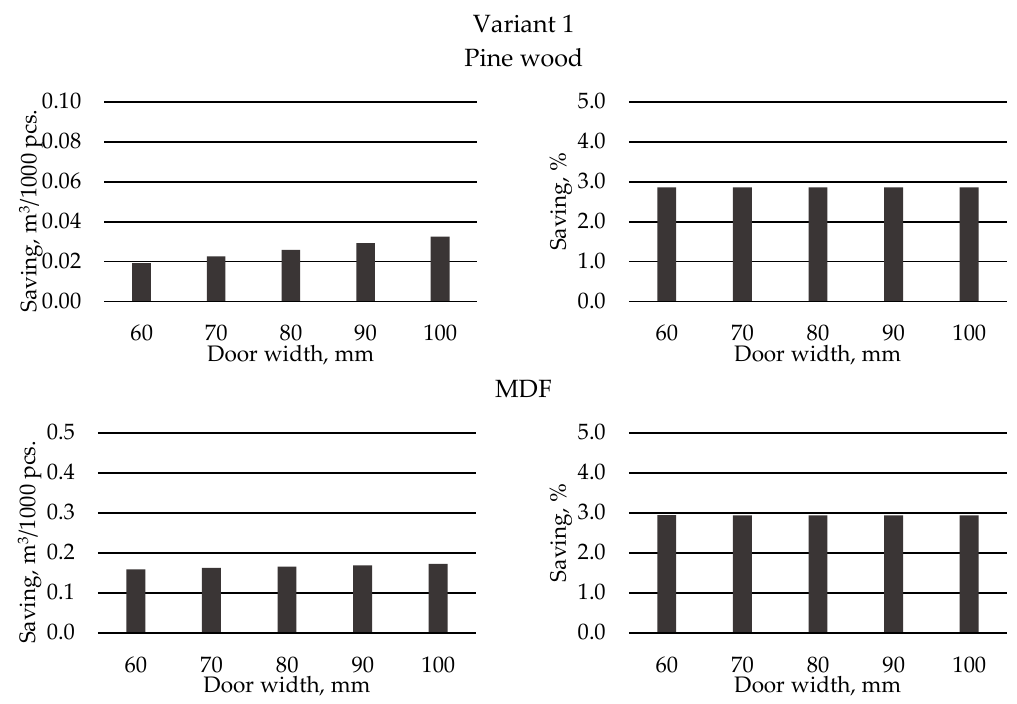
Figure 9. Material savings obtained by reducing the machining allowance in construction 3. Due to the fact that construction 1 is based on wide, wooden frames, it was possible Variant 1 to achieve a large reduction in machining allowance by as much as 4 mm. Therefore, the Oak wood saving of wood in variant 1 amounted to over 0.5 m 3 /1000 pieces. The larger the leaf dimensions, the slightly greater the saving. In percentage terms, this results in a 2.2% reduction in frame